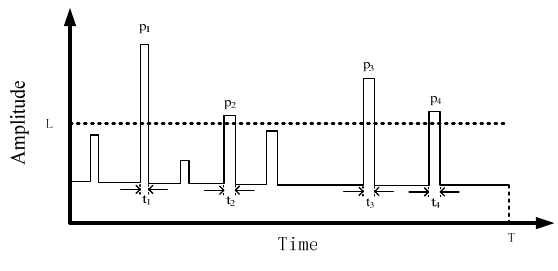
Figure 3. A simple envelope model.